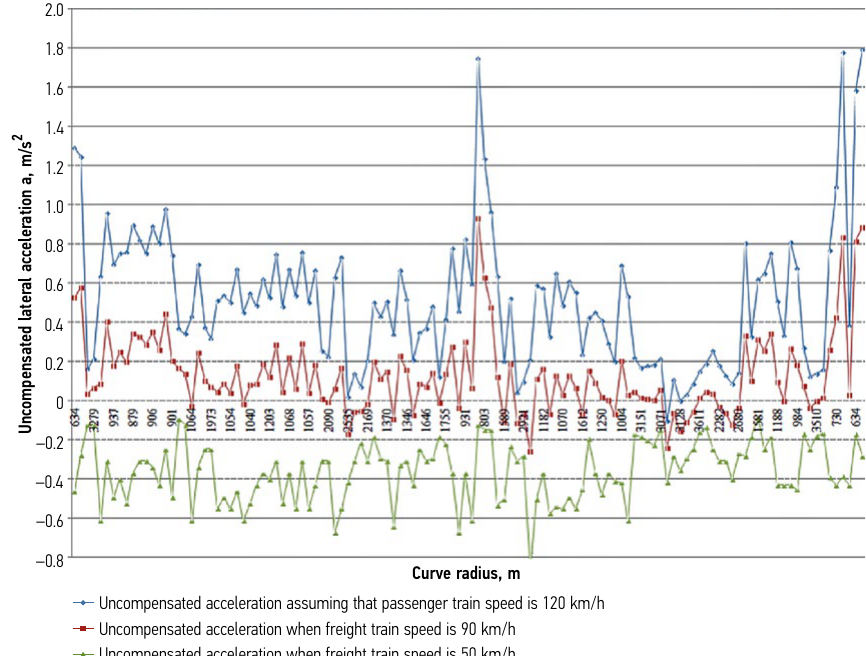
Fig. 5 . Uncompensated lateral acceleration calculated according to actual superelevations